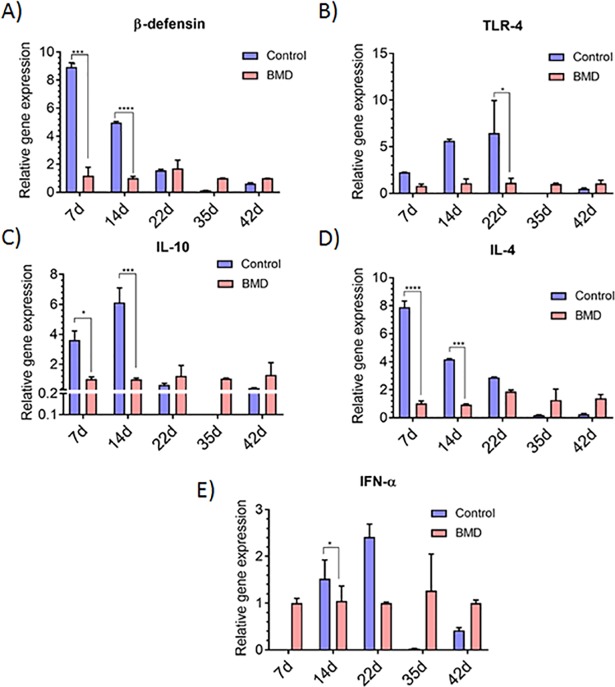
Change in cytokine gene expression (A) β-defensin (B) TLR-4 (C) IL-10 (D) IL-4 and (E) IFN-α in the ceca. Values are represented as means ± standard error of mean, where n = 4.